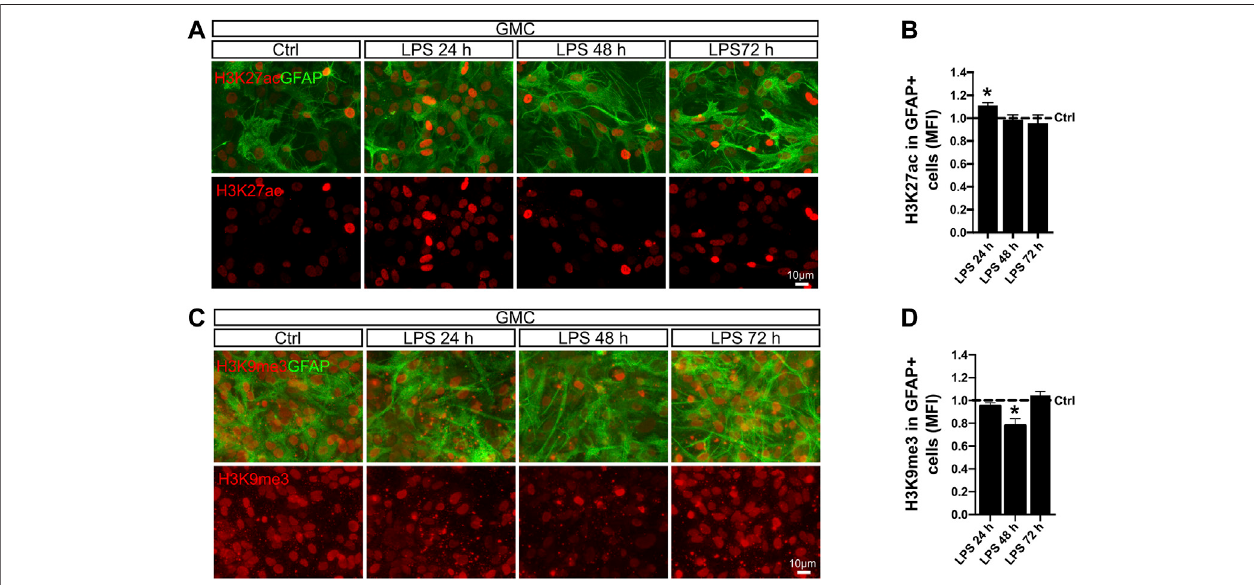
FIGURE5| LPSpromotesglobalchromatinremodelinginastrocytesinatime-dependentmanner. (A) Glialmixedcultures(GMCs)wereincubatedwithLPSduring the indicated time points in reduced-serum medium. To address changes in histone 3 acetylation at lysin 27 (H3K27ac) in astrocytes in response to LPS, we performed doubleimmuno fl uorescence stainingfor GFAPand H3K27ac. (B) Graphshowingthemean fl uorescence intensity (MFI)for H3K27ac inthe nucleiofGFAP-positivecells after normalizing to the control (Ctrl (cid:2) 1). Each time point was compared to the respective control (no LPS) using one-sample t -test with the statistical signi fi cance represented as * p < 0.05; n (cid:2) 3. (C) Glial mixed cultures (GMCs) were incubated with LPS during the indicated time points in reduced-serum medium. To address changesintrimethylatedhistone3lysin9(H3K9me3),immuno fl uorescencestainingforGFAPandH3K9me3wasperformed. (D) Graphshowingthemean fl uorescence intensity (MFI) for H3K9K9me3 in the nuclei of GFAP-positive cells after normalizing to the control (Ctrl (cid:2) 1). Each time point was compared to the respective control (no LPS) using one-sample t-test with the statistical signi fi cance represented as * p < 0.05, n (cid:2)